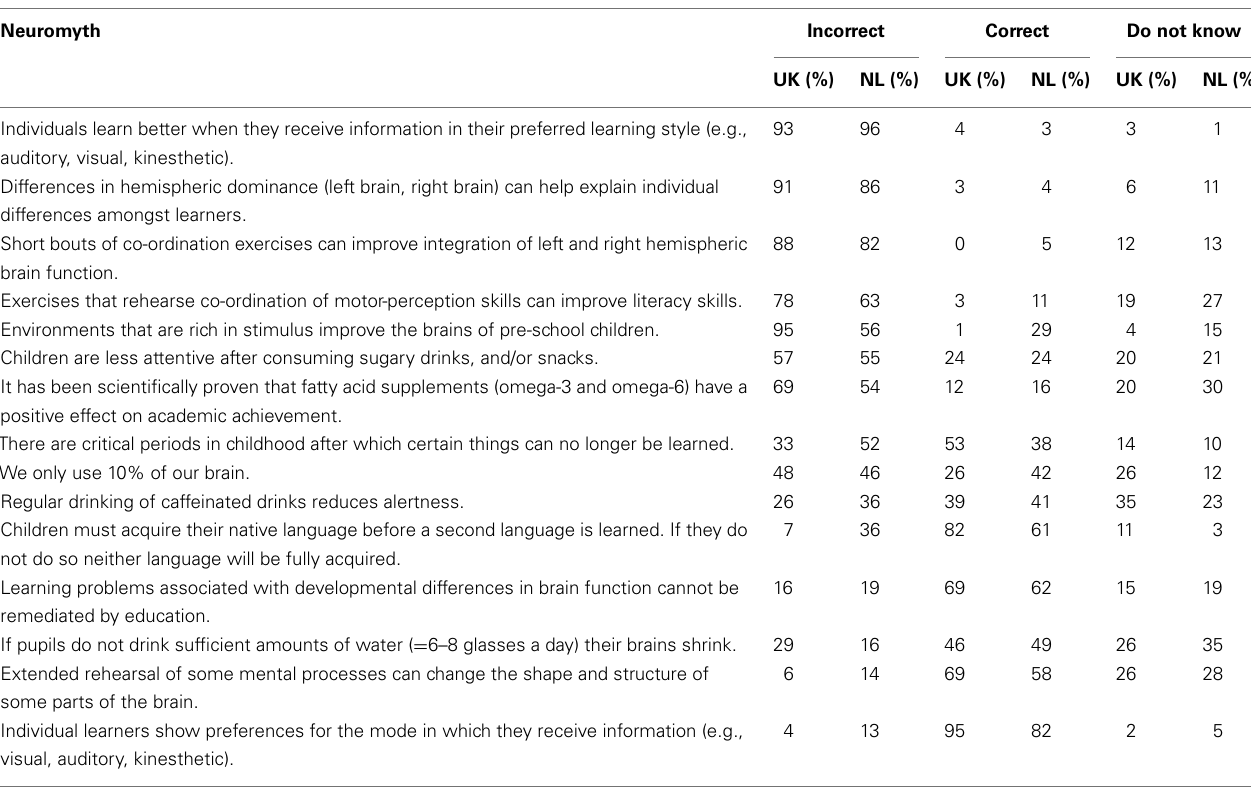
Table 1 | Correctness of responses for each myth assertion. Neuromyth